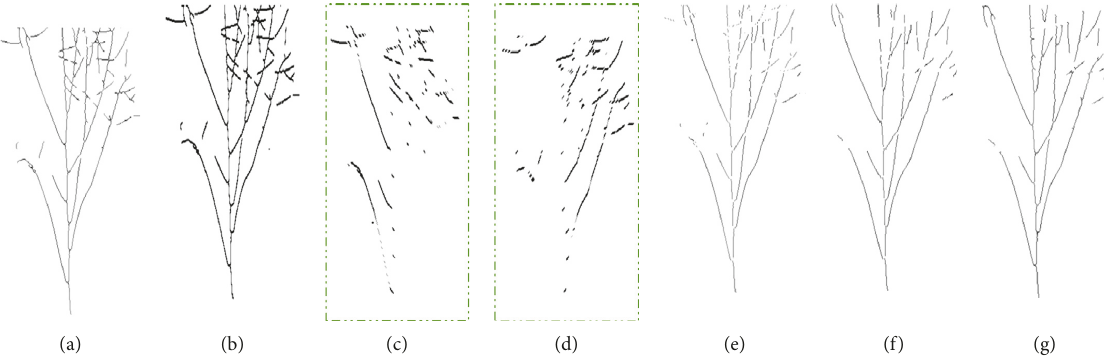
Figure 6: Removing of branches and siliqua: (a) skeleton images that are automatically trimmed, (b) dilate, (c) 45 ° erode, (d) 135 ° erode, (e) dilate image minus erode image, (f) remove small connected domains, and (g) dilate image ∗ binary